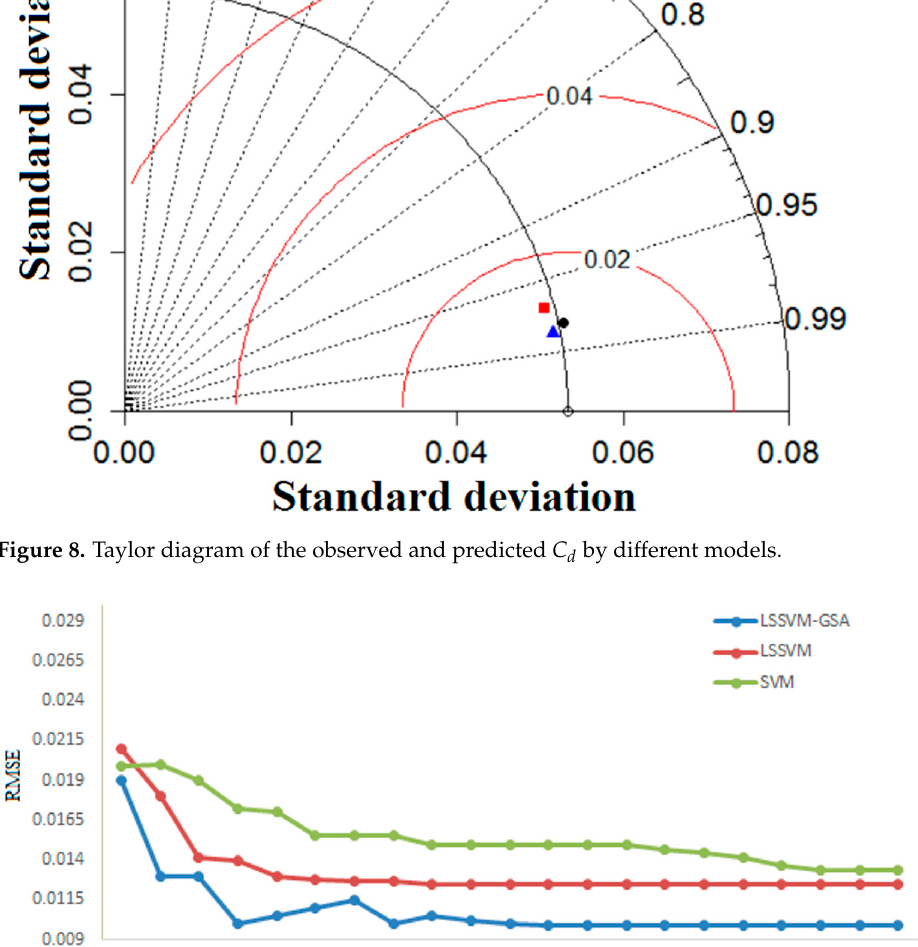
Figure 9. Convergence graphs of the implemented models for the last input combination. The outcomes of the methods were also assessed by one-way analysis of variance (ANOVA) to see the robustness (the possible significant differences between the obser- vations and model predictions) of the methods. The test was set at a significance level of 95%. Table 6 sums up the test results. As observed from the table, the LSSVM − GSA yielded a smaller testing value (0.00004) with a higher significance level (0.995) compared to LSSVM and SVM, and this indicates that the LSSVM − GSA is more robust in predicting the discharge coefficient of triangular side orifices than the other